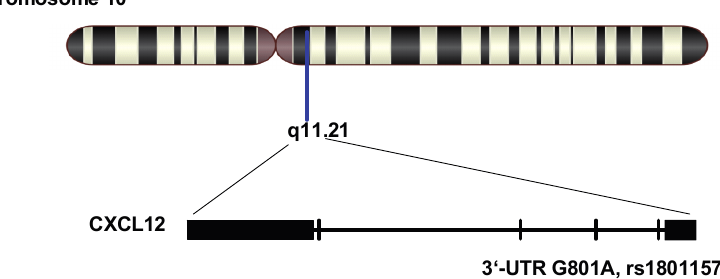
Figure 1. Diagram of rs1801157. SDF-1 , also known as CXCL12 , is encoded by the CXCL12 gene located at q11.21 on chromosome 10. rs1801157 is located at position 801 in the